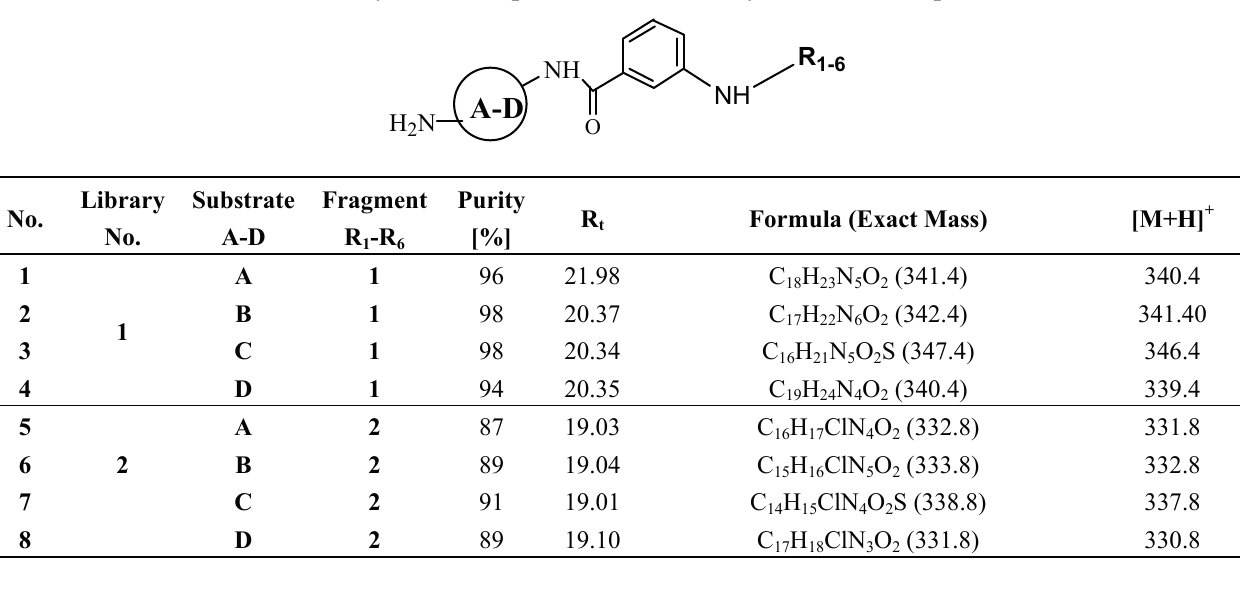
Table 1. Analytical and spectral data of the synthesized